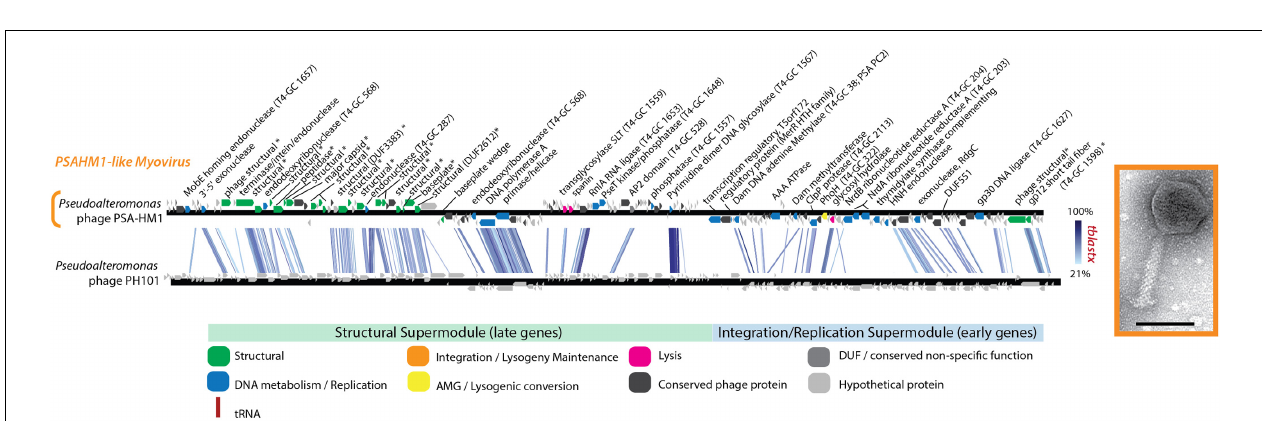
FIGURE 6 | Full-genome comparison based on TBLASTX similarity between PSA-HM1 and Pseudoalteromonas phage PH101. These phages do not belong to the same genera, based on genome similarity criteria. ∗ Denotes proteins confirmed as structural by mass spectroscopy-based